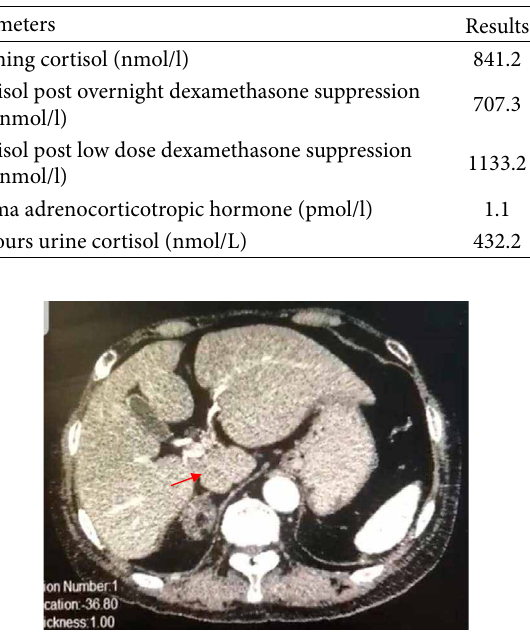
Figure 1: CT scan adrenal showing right adrenal